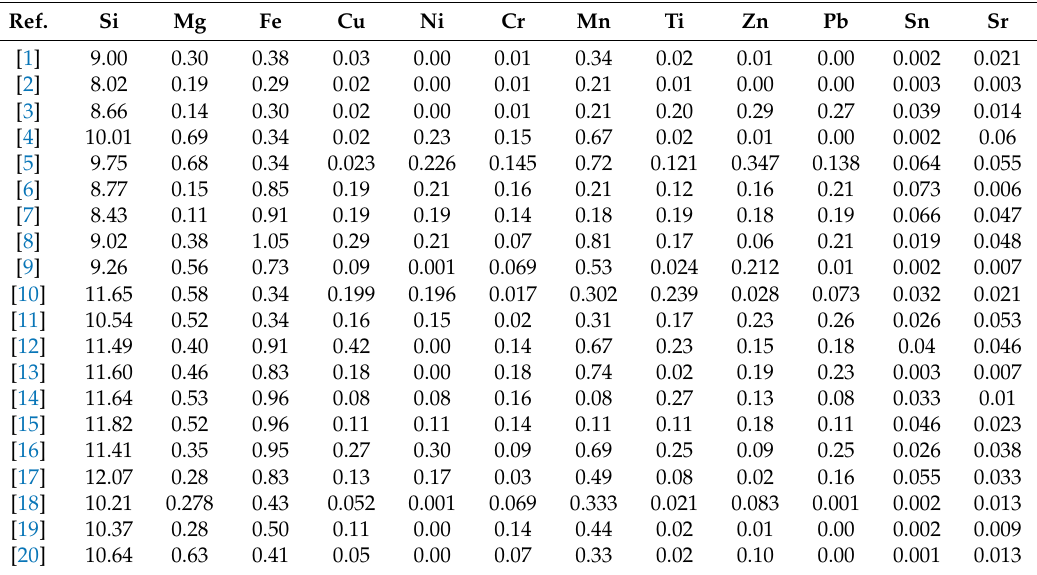
Table 1. The compositions of base alloys (mass